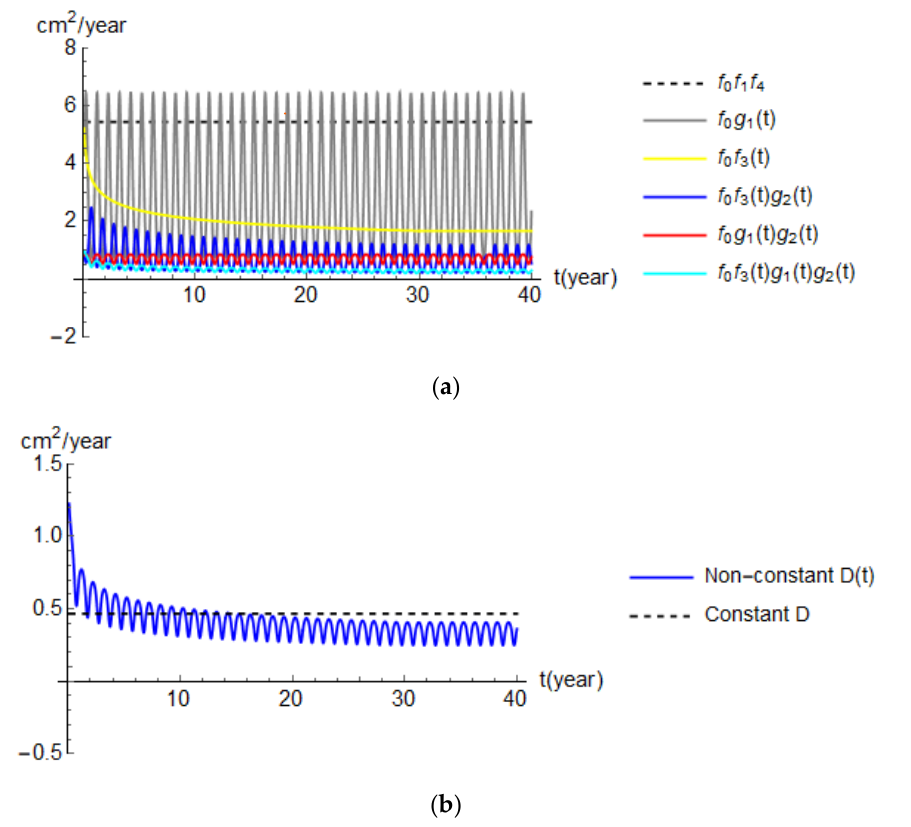
Figure 7. Diffusivity: ( a ) factor trends with respect to the reference constant f 0 factor; ( b ) non-con- stant and constant D with all